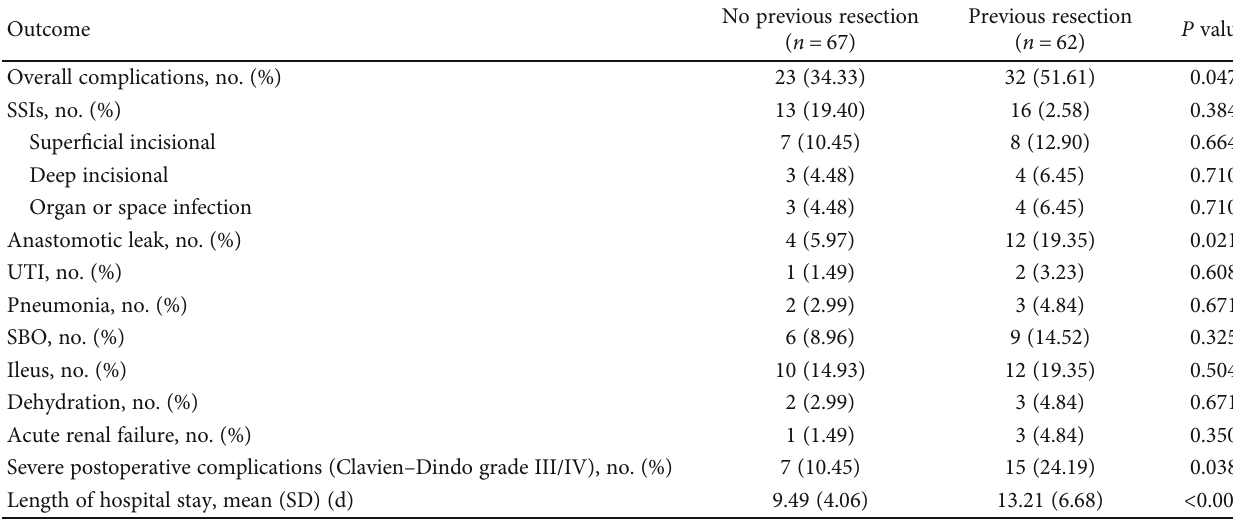
Table 3: Postoperative outcomes.